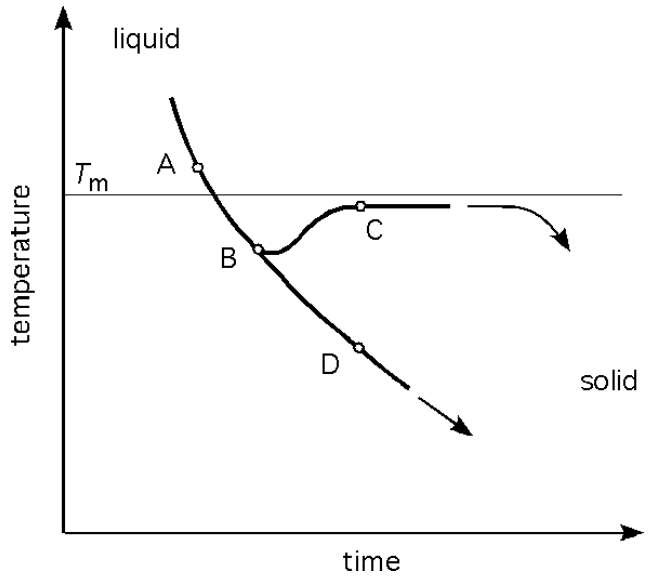
Figure 3. A portion of a cooling curve of a system undergoing solidification. T equilibrium melting temperature. If nucleation and crystal growth occur the path follows A-B-C; if crystallisation does not occur, the path will continue along